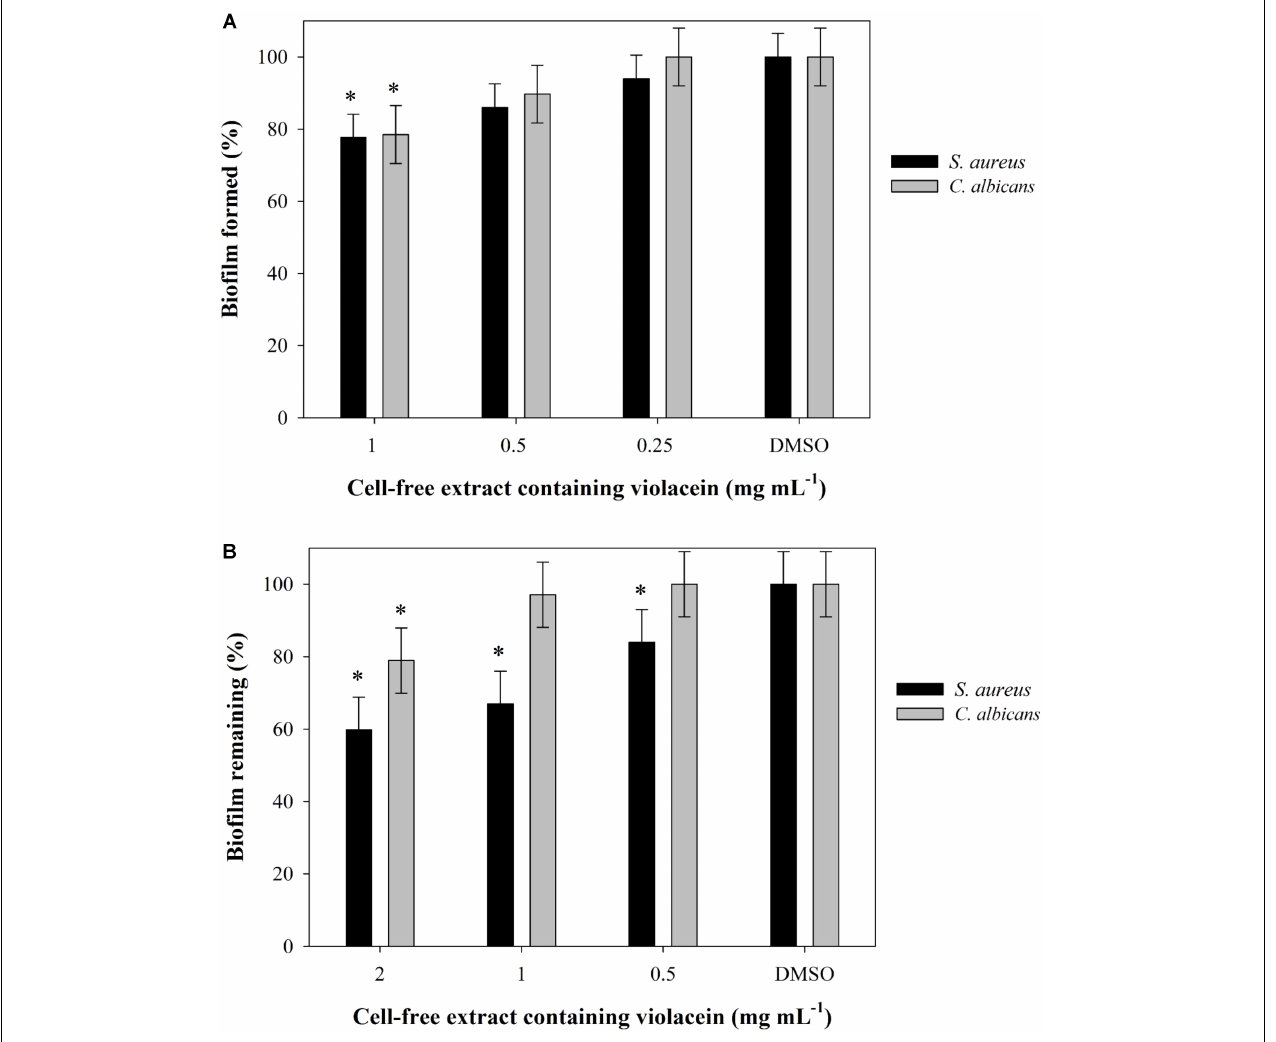
FIGURE 5 | (A) Biofilm formation and (B) biofilm disruption at different concentrations of cell-free extract containing violacein in DMSO. Statistical significance ( p < 0.05) values from control are denoted by